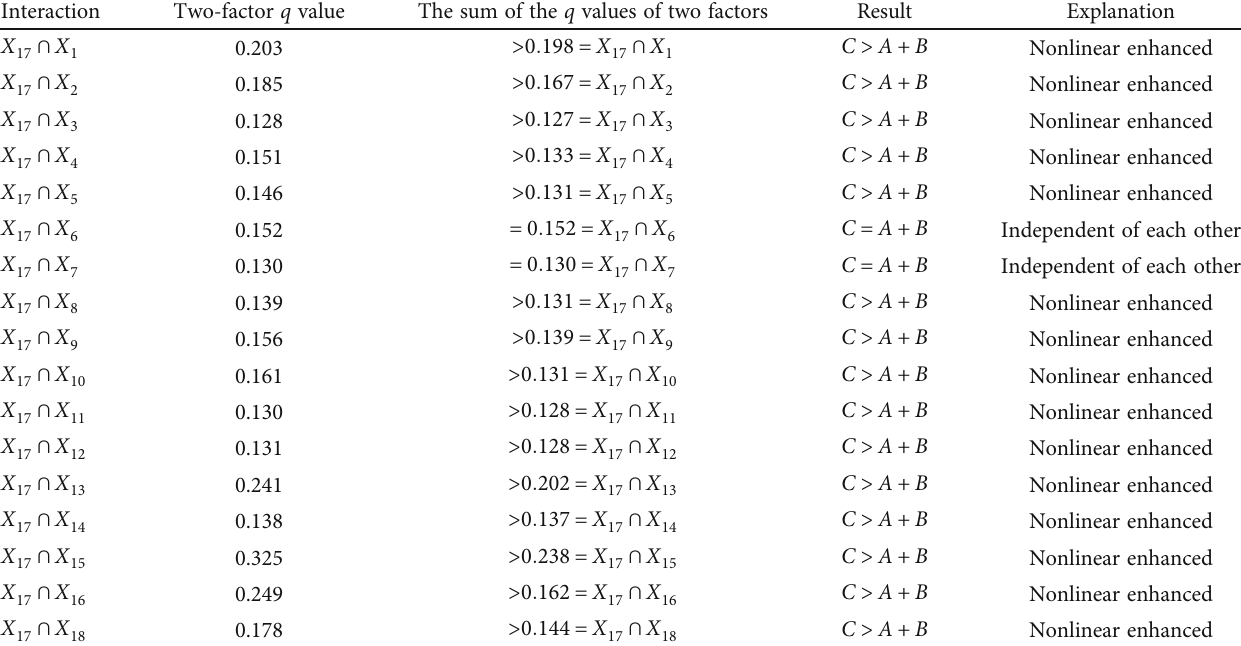
Table 7: The dominant interactions between two covariates in gully